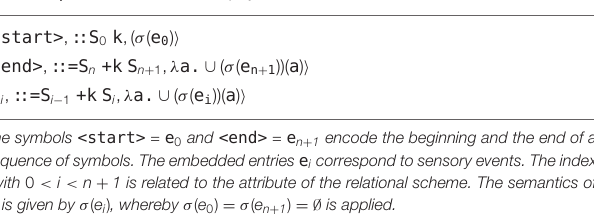
TABLE 1 | Minimalist lexicon for physical